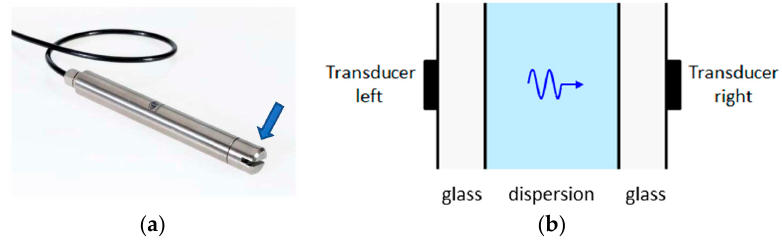
Figure 1. ( a ) The ultrasound nanoparticle sizer (UNPS) probe with a diameter of 18 mm (image published with permission of Sonaxis); ( b ) sketch of the basics of the method to measure the speed of sound and attenuation of ultrasonic waves in a dispersion.